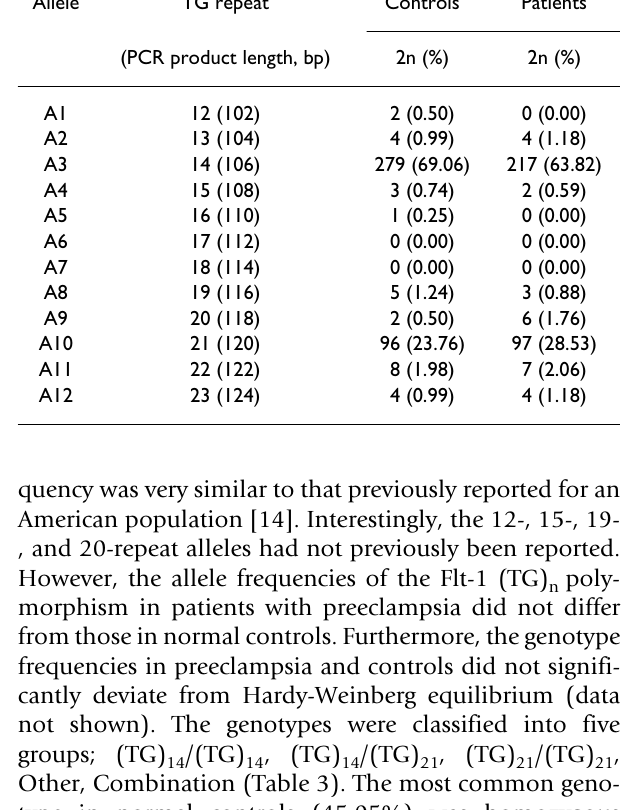
compared each reference group [(TG)